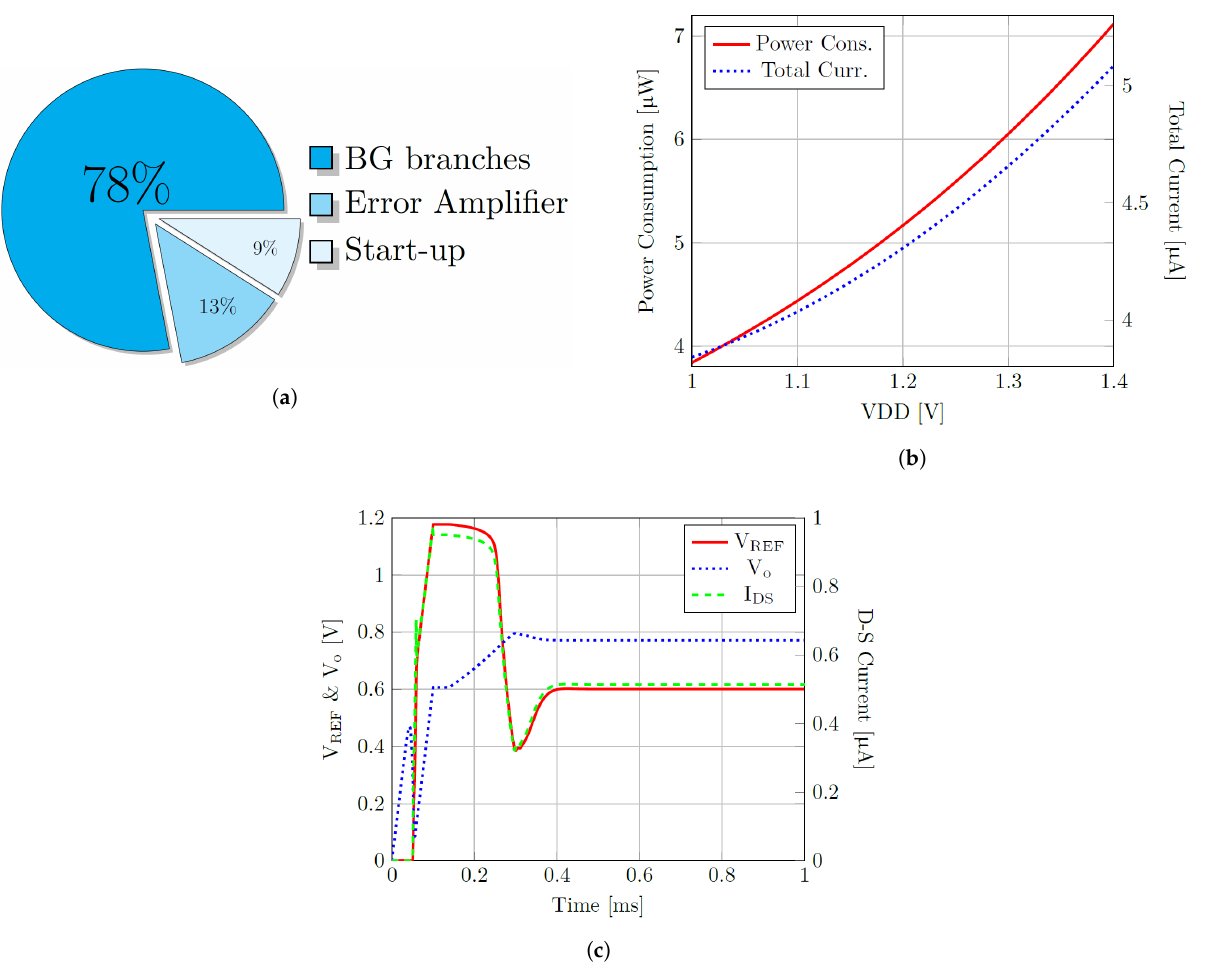
Figure 8. ( a ) Power breakdown of the designed circuit. ( b ) Power consumption and total current vs. VDD. ( c ) Start-up transition behavior of V REF , V o and I DS of